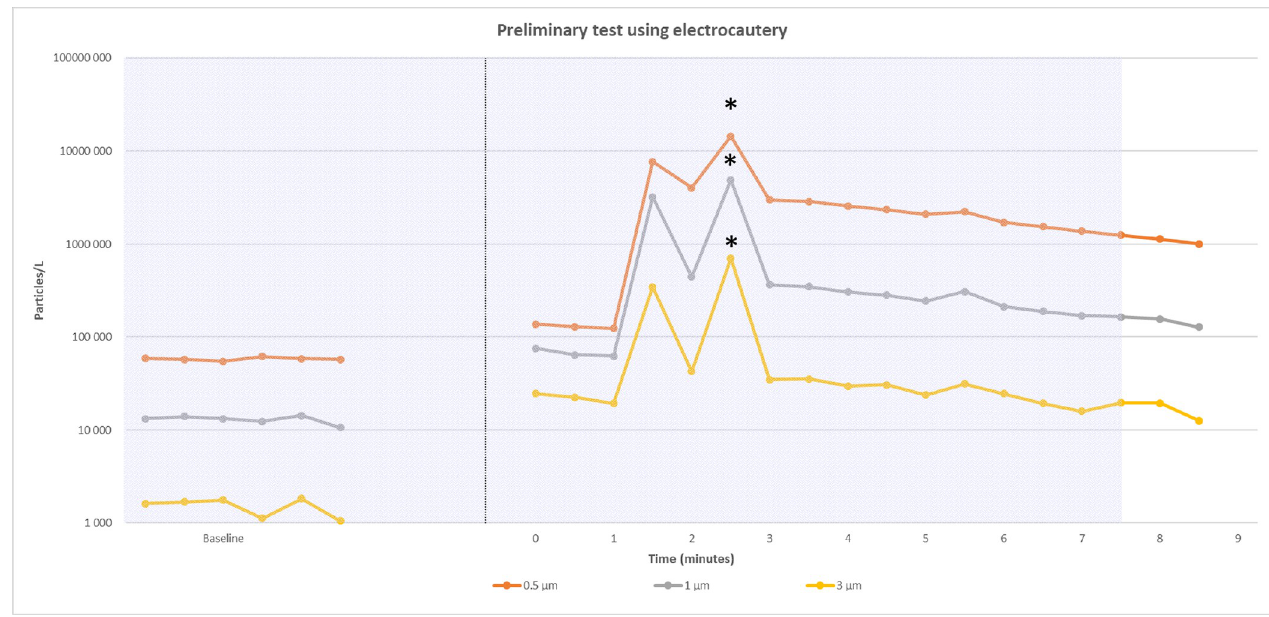
Fig 1. Impact of electrocautery use on particle count during a preliminary test: Preliminary data experience showing the dramatic increase in particle count after electrocautery at T = 0. Hatching in the background: Intensive care ventilator on; white in the background: Intensive care ventilator off; � significant